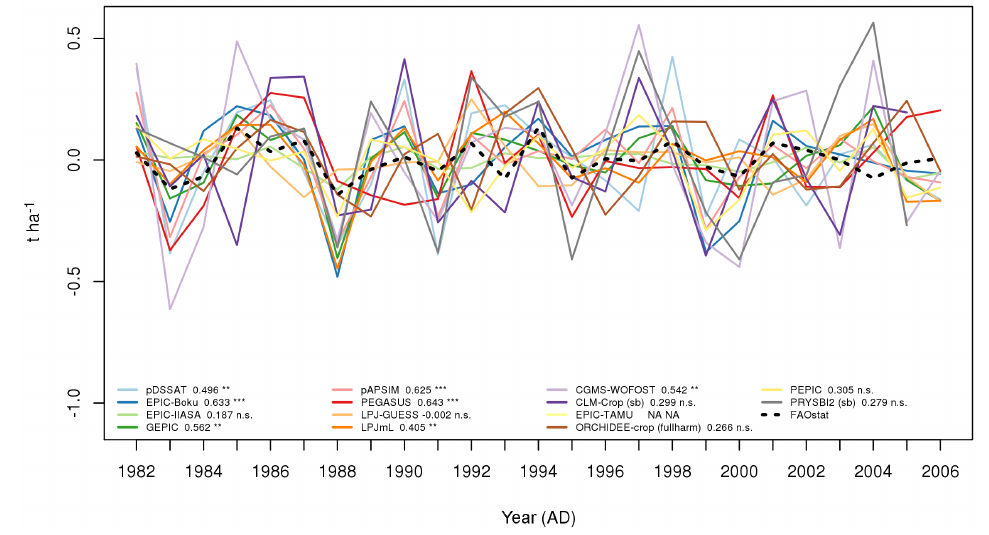
Figure 4. As Fig. 1 but for soybean. EPIC-TAMU did not supply data for soybean.